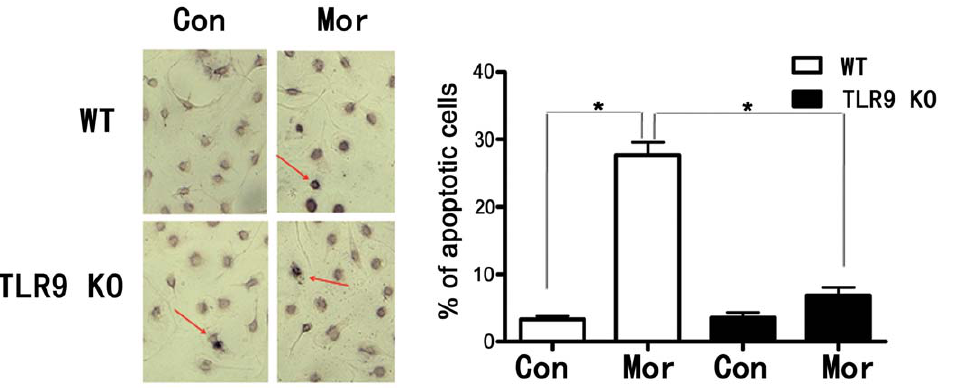
Figure 2. A deficiency of TLR9 is resistant to morphine-induced microglia apoptosis. Wild type (WT) and TLR9 deficient (TLR9 KO) microglia were treated with or without 10 m M morphine for 24 hr. Apoptotic cells (dark brown color cells) were determined by TUNEL assay. Photographs of representative TUNEL-stained cells are shown at the top. Magnification 200 6 . The bar graph shows the percentage of apoptotic cells. Results represent mean 6 SD from three independent experiments. * p , 0.01 compared with indicated groups.